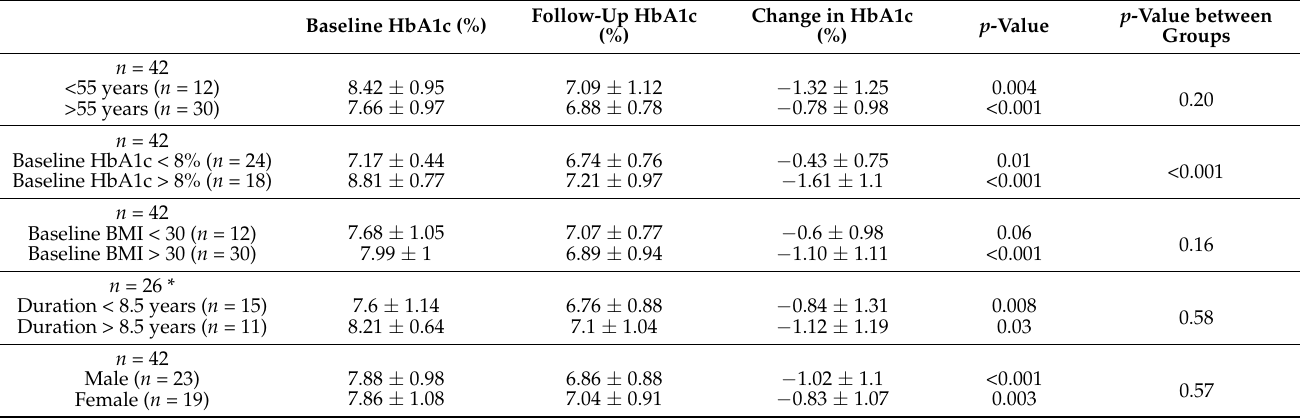
Table 2. Subgroup